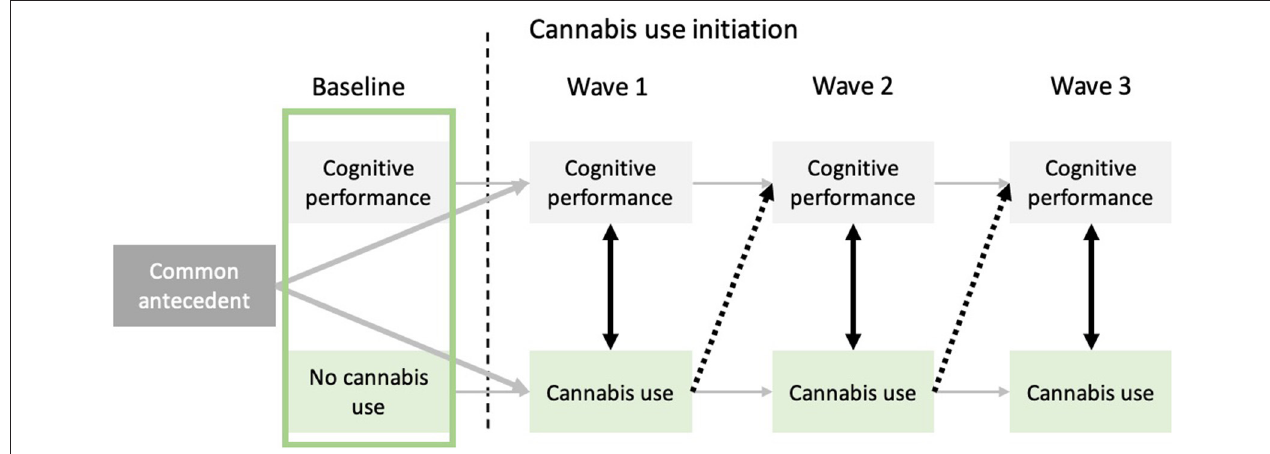
FIGURE 1 | Representation of the cognitive vulnerability, concurrent, and neurotoxicity hypotheses relative to the association between cannabis use and cognitive functioning. The cognitive vulnerability hypothesis (represented by the green square) posits that before onset of cannabis use, future cannabis users already exhibit cognitive deficits. The common antecedent hypothesis, which offers a more general framework than the cognitive vulnerability hypothesis, posits that unknown common factors could be responsible for cannabis use onset and mild cognitive deteriorations, without cannabis use being the causal factor of the aforementioned cognitive deficits. Black dotted arrows allow to investigate the neurotoxic hypothesis by testing if previous cannabis use ( t − 1) predicts subsequent cognitive functioning ( t ), while controlling for frequency of cannabis use at time t. Lastly, black bidirectional arrows between cognitive abilities and cannabis use at every time-point represent the concurrent hypothesis. Indeed, cognitive performance at time t is associated with cannabis use at time t, without necessarily persisting effects through